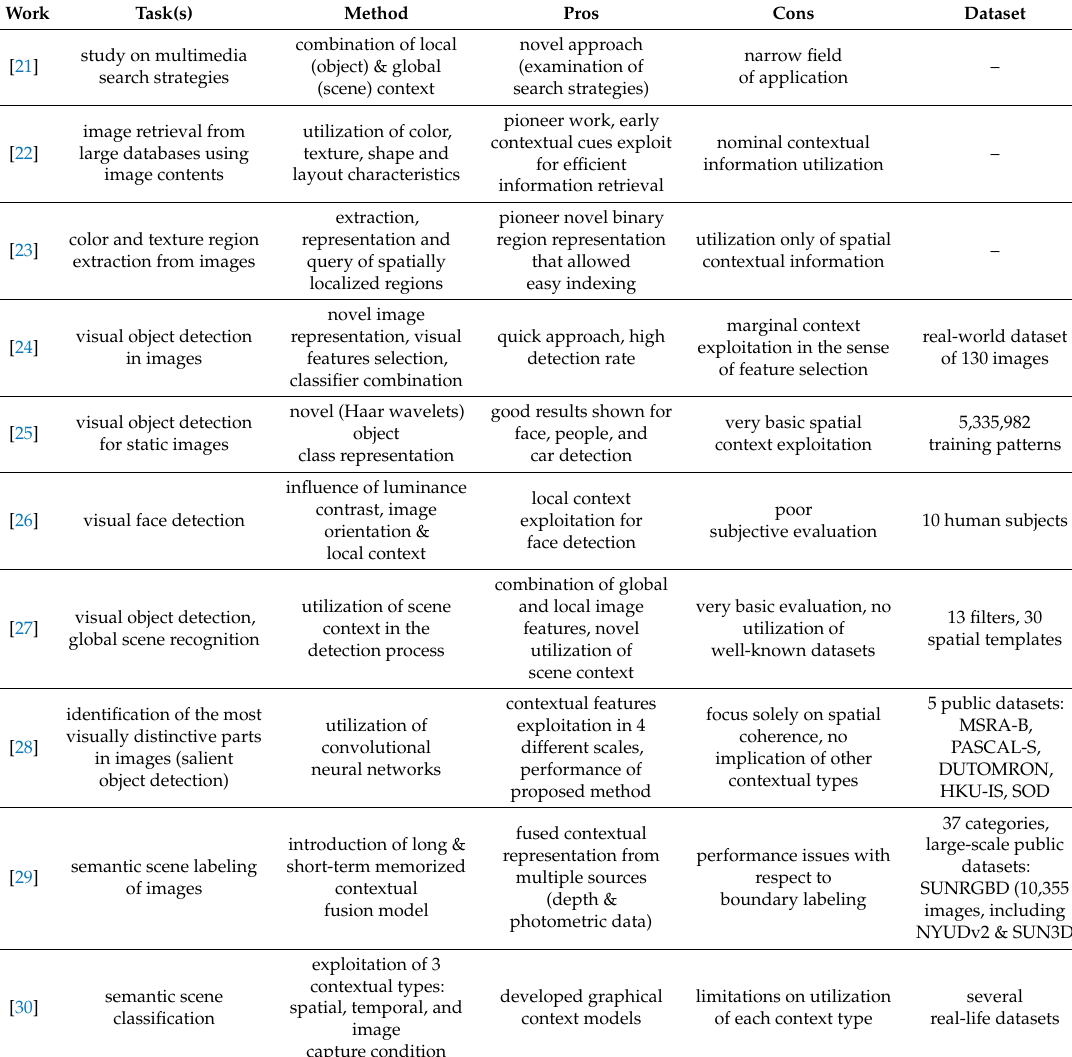
Table 3. Scene context